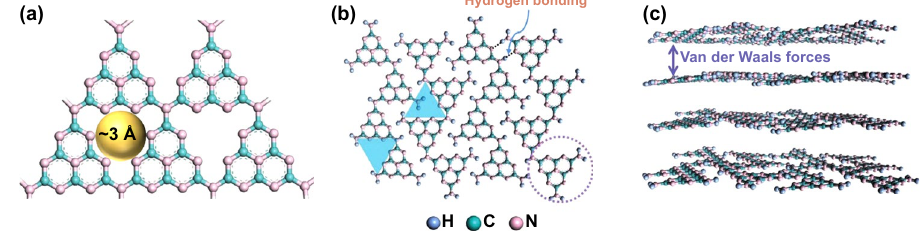
Fig. 2 a Tri‑s‑triazine unit of g‑C 3 N 4 . b Plane repeats and c π–π stacking structure of g‑C 3 N 4 [37]. Copyright 2021,